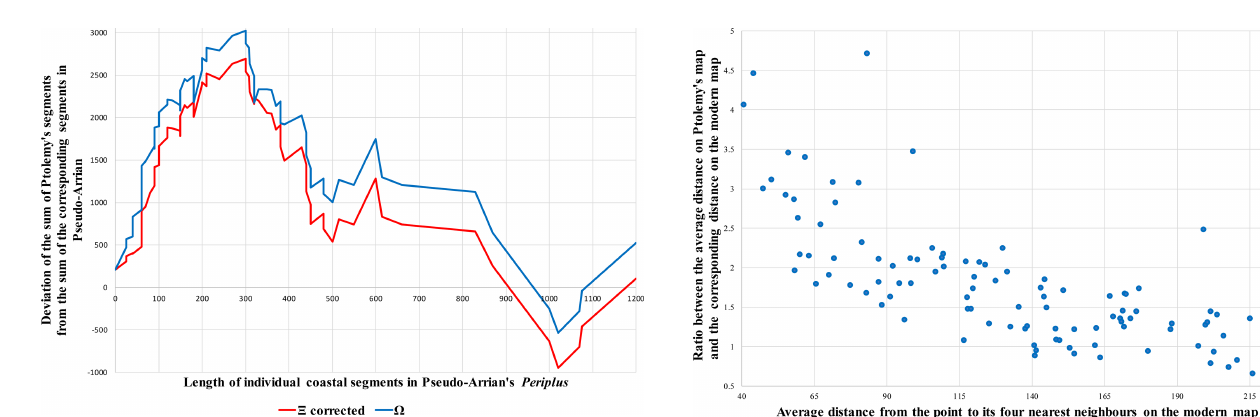
Figure 7. The overestimation of the average distances between neighbouring points on Ptolemy’s map compared with the corre- sponding distances on the modern map as a function of the den- sity of their distribution on the modern map. The x axis shows the average distance from each of the 106 points on the coasts of the Pontus to its four nearest neighbours, calculated using their modern coordinates. The y axis shows the ratio between the corresponding average distance value calculated using Ptolemy’s coordinates and the average distance value indicated on the x